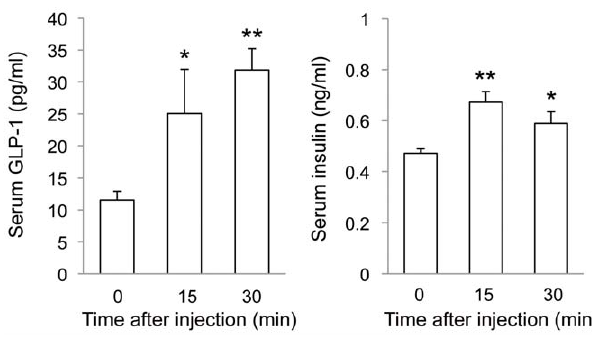
Figure 7. Effects of intravenous injection of ucOC on serum GLP-1 and insulin levels. Mice deprived of food for 5 h (blood glucose level, 103.5 mg/dl) were injected with ucOC (30 ng per animal) via the tail vein, and blood samples were collected 15 and 30 min thereafter for measurement of the serum concentrations of GLP-1 and insulin. Data are means 6 SEM for four to six mice. * P , 0.05, ** P , 0.01 versus time 0 (Student’s t